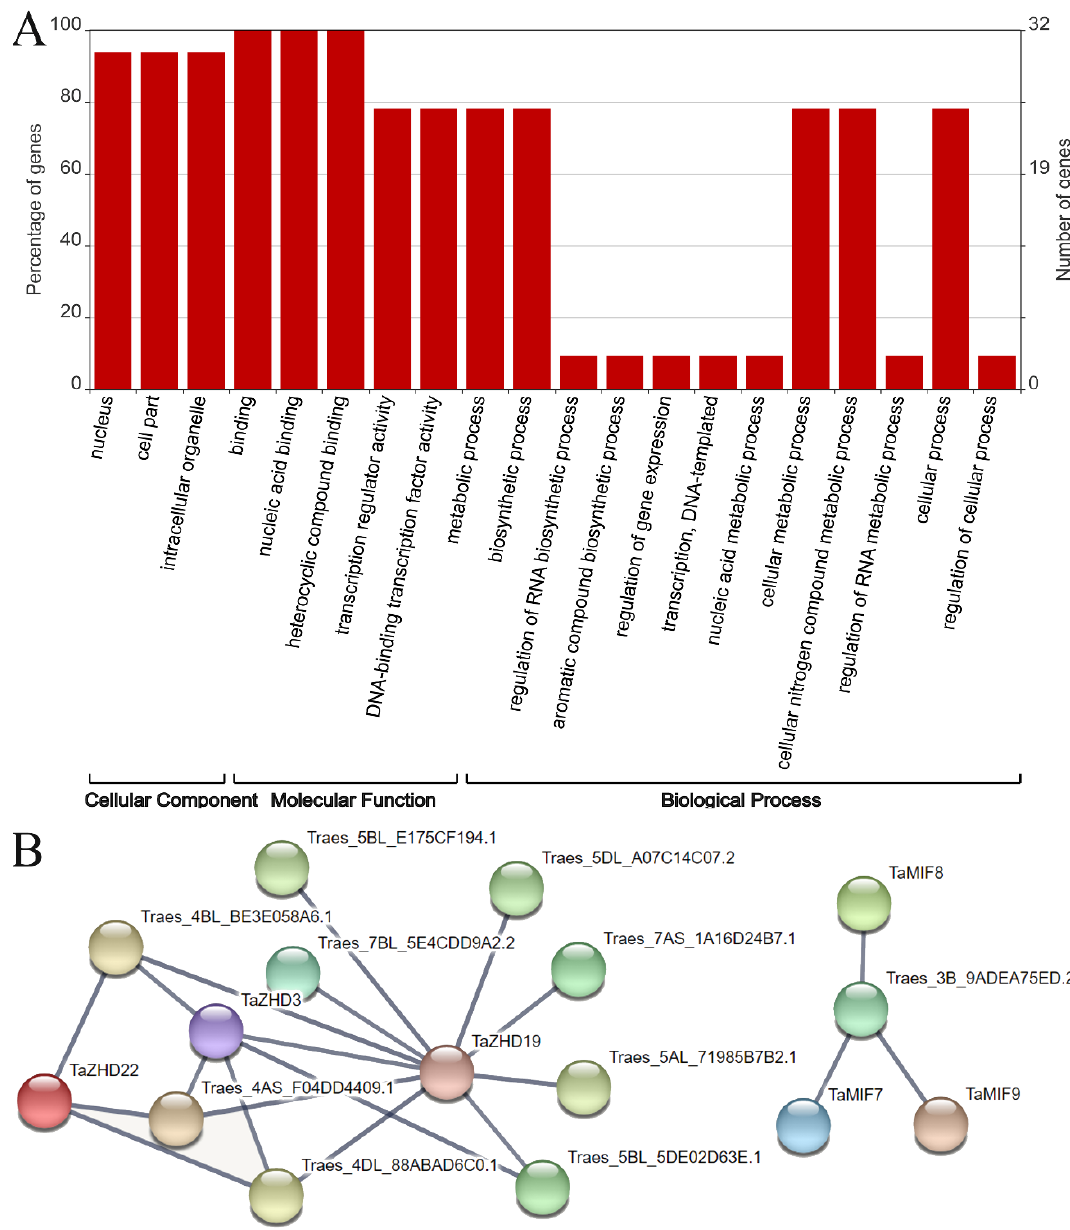
Figure 9. Gene ontology (GO) annotation ( A ) and protein-protein interactions ( B ) analysis of TaZF-HD proteins.